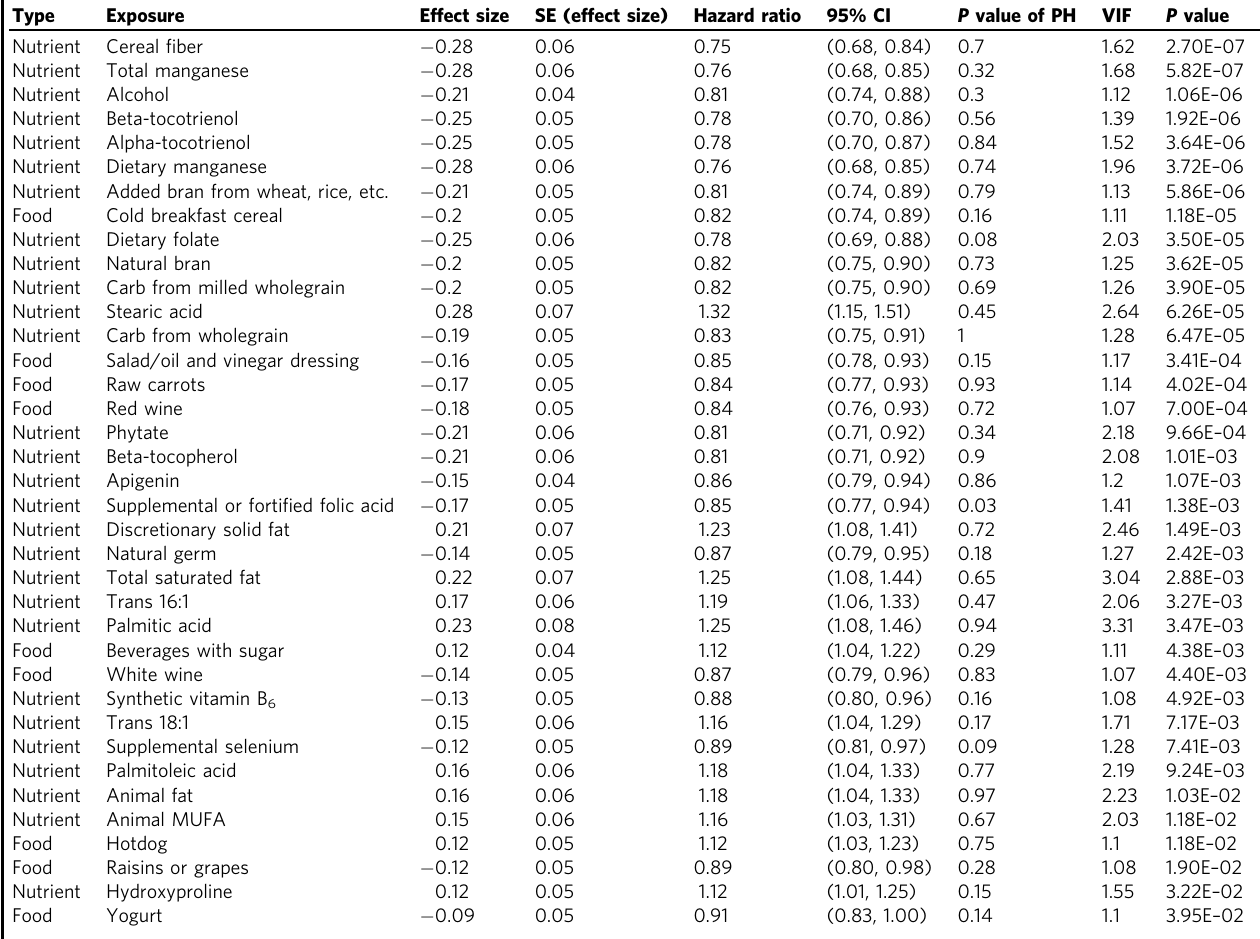
Table 2 Validation in NHS